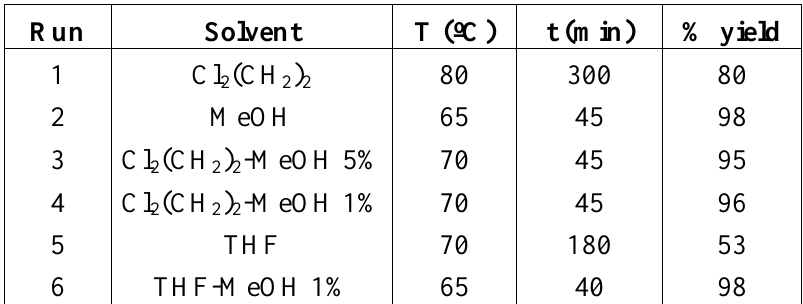
Table 1 . Deprotection of 1 using 1% of bulk Well-Dawson